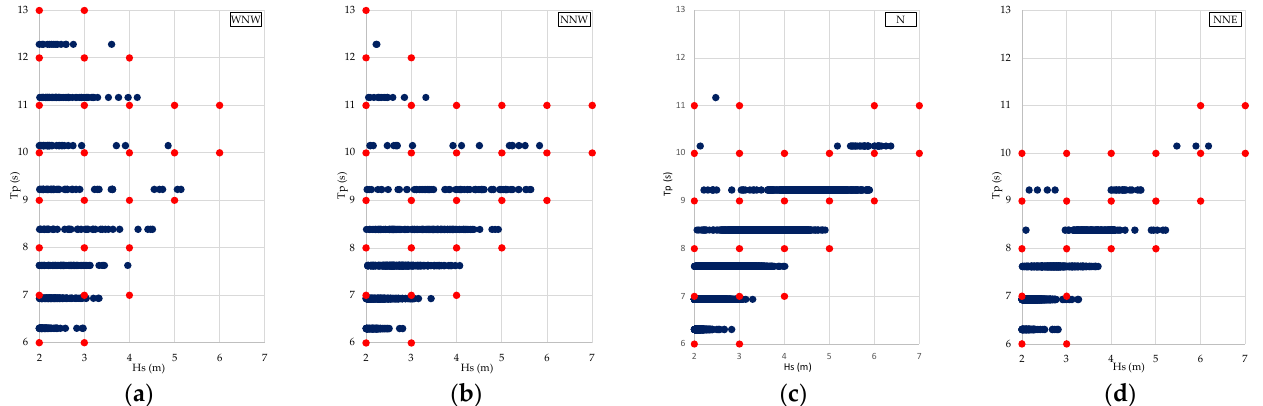
Figure 7. Pairs of offshore wave heights and peak periods from the available dataset (blue dots) and selected pairs (red dots) for training the ANN; ( a ) WNW direction, ( b ) NNW direction, ( c ) N direction and ( d ) NNE